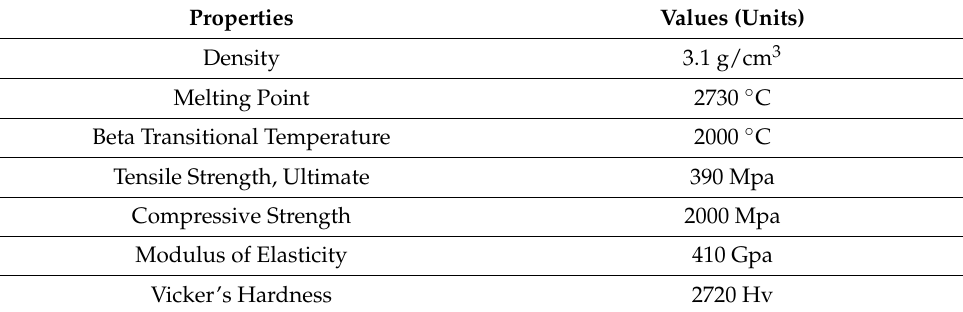
Table 4. Thermal properties and Mechanical Properties of SiC [20].